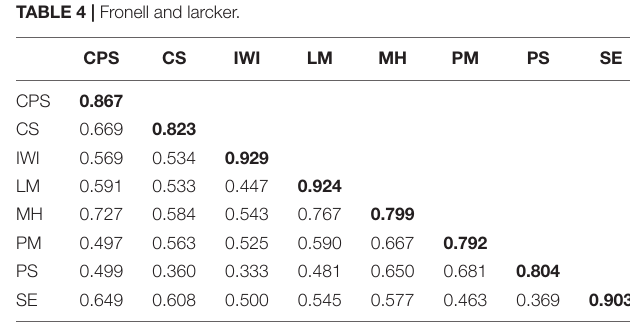
TABLE 4 | Fronell and larcker.